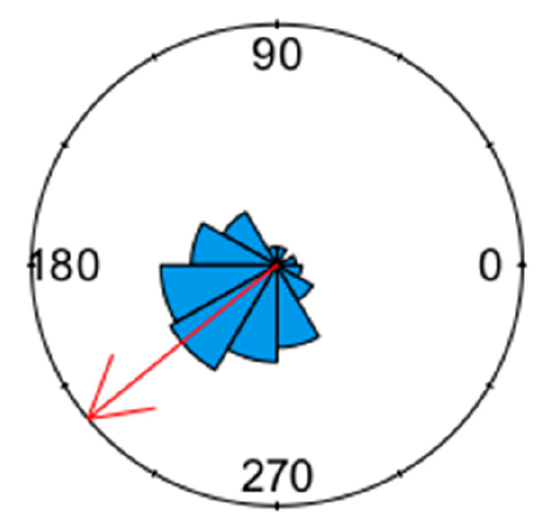
Figure 2. Circular plot of the number of LCSB male moths collected in delta traps at Jay, Santa Rosa County, Florida. The Rose diagram indicates the relative frequency of the moths collected across the days of the year from 0 ◦ (January 1) to 360 ◦ (December 31). The red arrow indicates the mean direction of abundance (219.68 ◦ , month = August).